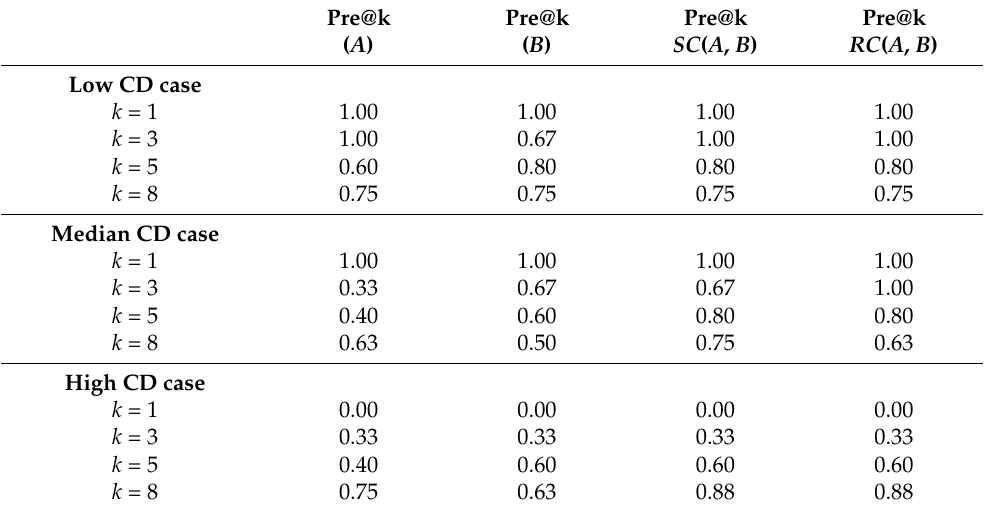
Table 7. Precision results of Models A, B, SC ( A , B ) and RC ( A , B ) for low, median, and high cognitive